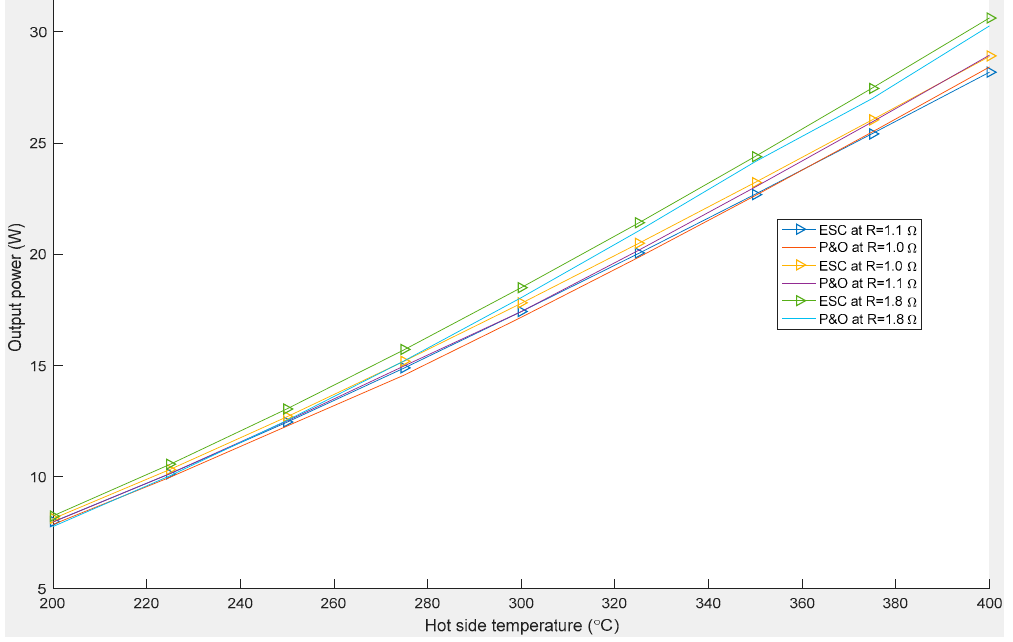
Figure 18. Output of ESC and P&O near the optimum point.